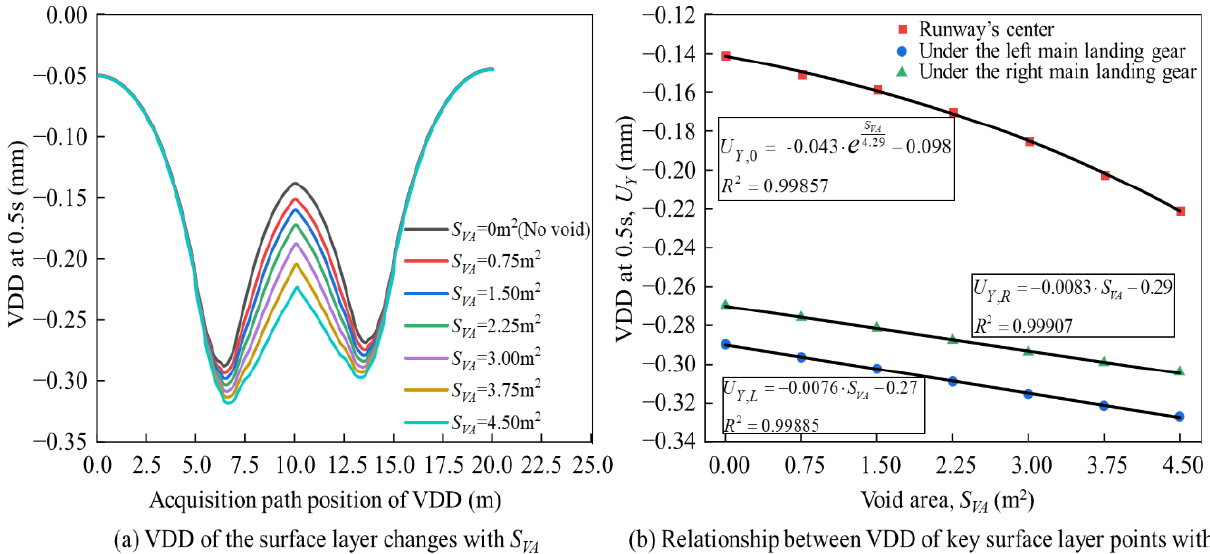
Figure 12. VDD of pavement in case of severe void.